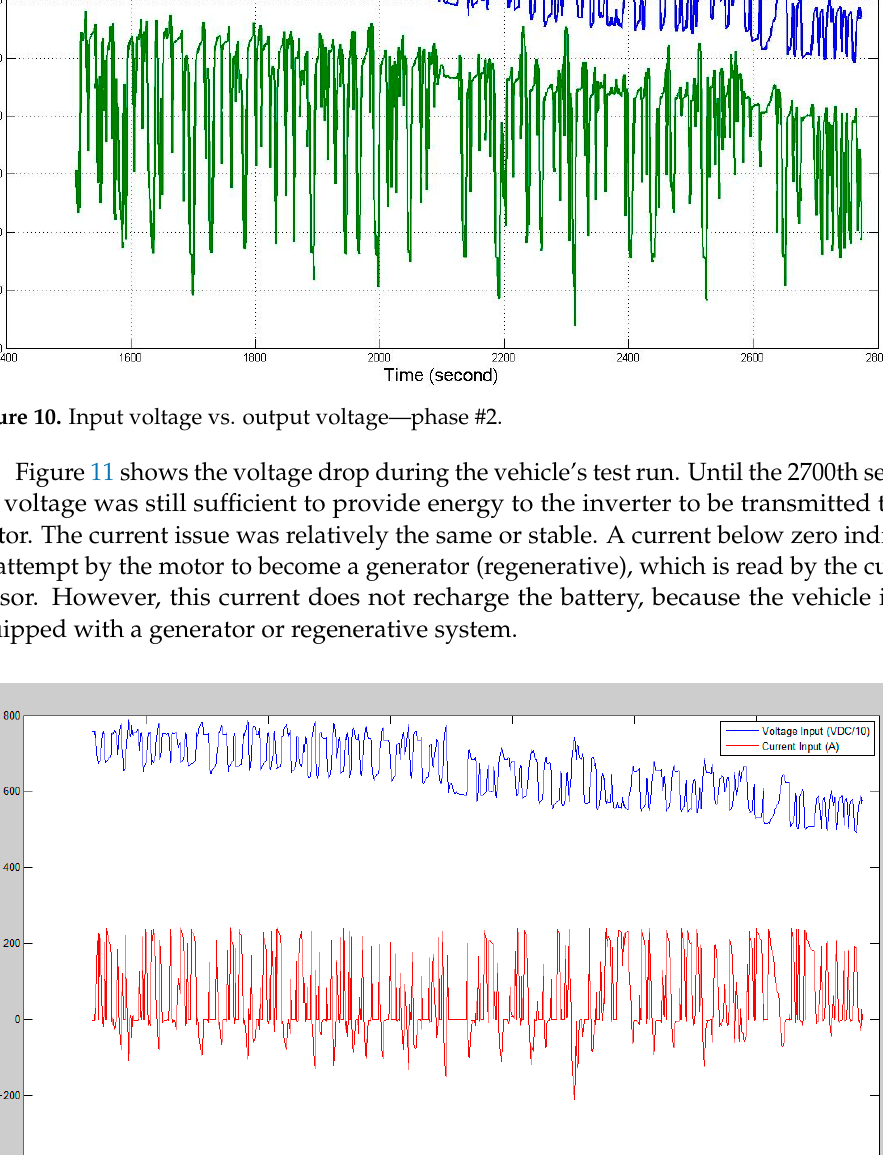
Figure 10. Input voltage vs. output voltage—phase #2.